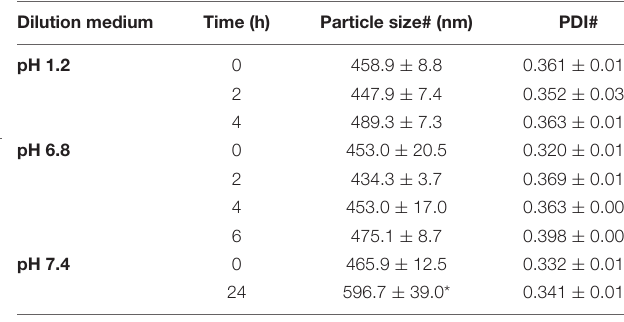
TABLE 4 | Change in particle size and PDI of CLEN with